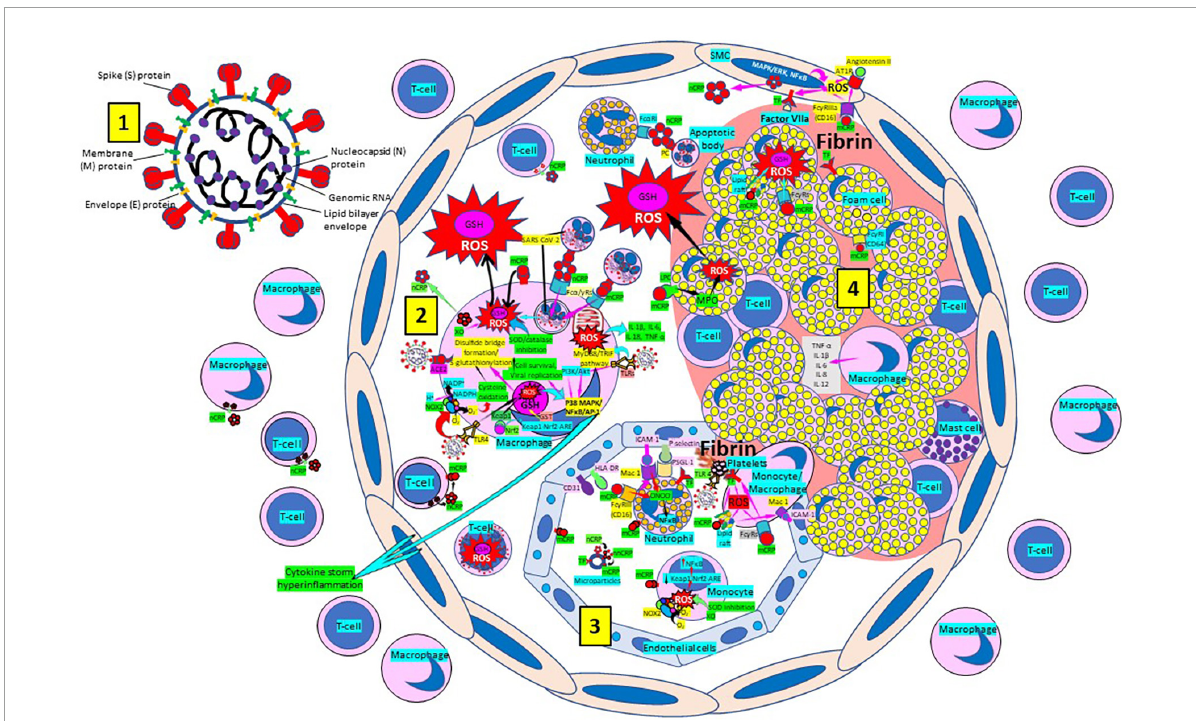
FIGURE9 Severe acute respiratory syndrome coronavirus-2 (SARS-CoV-2) enhances oxidative stress and atherosclerosis progression. (1) SARS-CoV-2 structure. (2) SARS-CoV-2 viruses facilitate oxidative stress and inflammation in the arterial intima. Native C-reactive protein (nCRP), a marker of severe SARS-CoV-2 produced in liver, macrophages, lymphocytes, smooth muscle cells (SMC) and other cells, promotes inflammation through monomeric CRP (mCRP) enhancing intimal oxidative stress. SARS-CoV-2 binds macrophage toll-like receptor (TLR) 4 and facilitates nicotinamide adenine dinucleotide phosphate (NADP)H oxidase 2 (Nox2) activity and superoxide (O 2 − ) production causing cysteine oxidation, disulfide bridge formation and S-glutathionylation. Xanthine oxidase (XO) and inhibition of superoxide dismutase (SOD)/catalase further facilitate O 2 − cellular activity. SARS-CoV-2 can bind TLRs 2 and 4 and activate transcription factors like nuclear factor (NF)- κ B facilitating cytokine storm and hyperinflammation. Excessive mitochondrial reactive oxygen species (ROS) generation further enhances cytokine production. CRP (nCRP, mCRP) can facilitate macrophage and neutrophil uptake of SARS-CoV-2-infected apoptotic cells through Fc γ and Fc α receptors, respectively (FcRs). Oxidative stress also activates the Kelch-like ECH-associated protein 1 (Keap1)-Nuclear factor erythroid 2-related factor 2 (Nrf2)-antioxidant response element (ARE) redox regulator pathway in monocytes [see (3) and macrophages (2)], releasing Nrf2 to regulate the expression of genes that control antioxidant enzymes like glutathione S-transferase (GST), facilitating glutathione (GSH) activity.